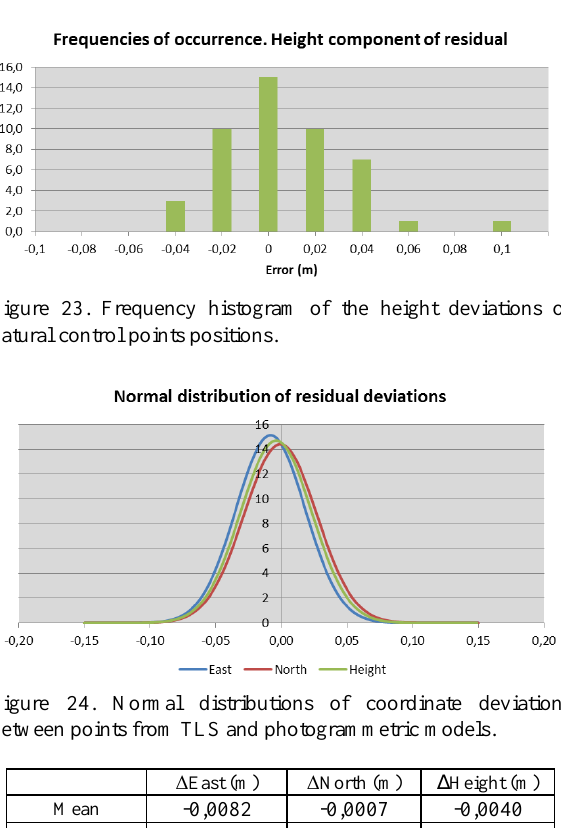
Figure 22. Frequency histogram of the deviations in North component of natural control points positions.